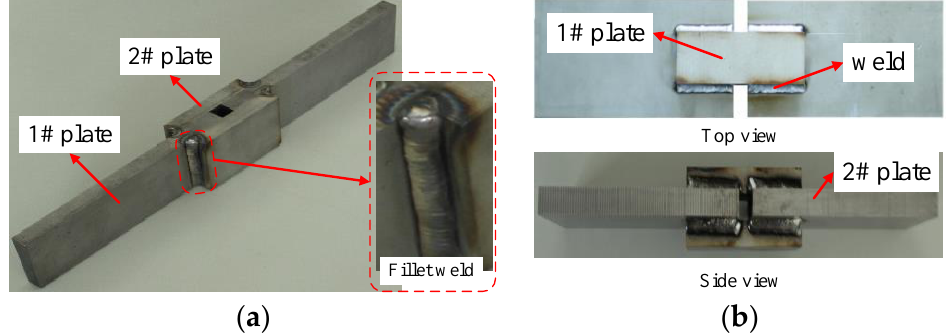
Figure 1. AWS standard test specimens: ( a ) transverse welded specimen; ( b ) longitudinal welded specimen. (1# and 2# indicate the plate sequence number).